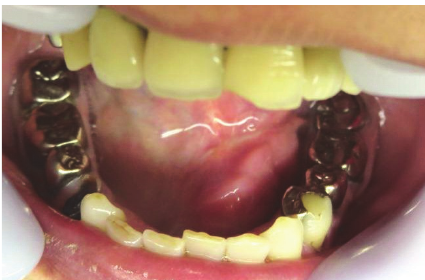
Figure 1: Intraoral examination. Examination of the oral cavity showed a 28 × 13mm hard elastic mass in the left floor of the mouth. The mucosal surface was normal, with no ulceration.